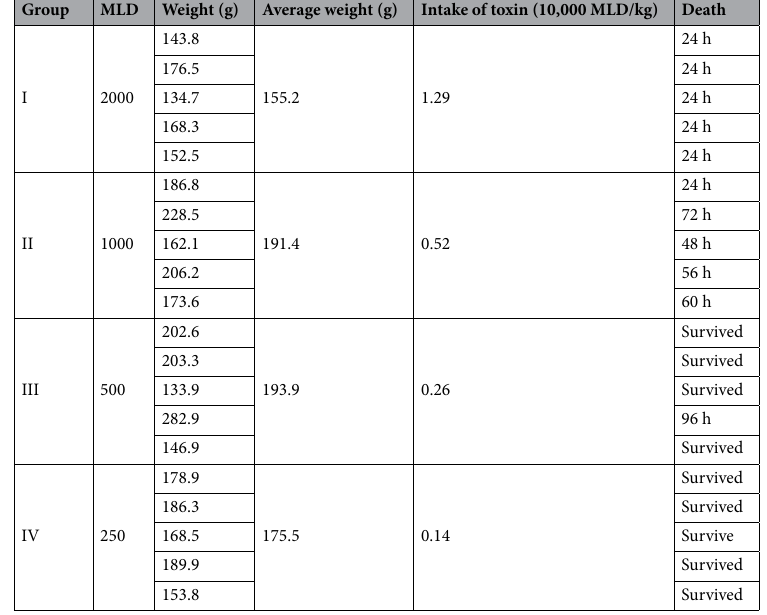
Table 2. Oral lethality test of different toxic mineralized toxin particles on plateau zokor.